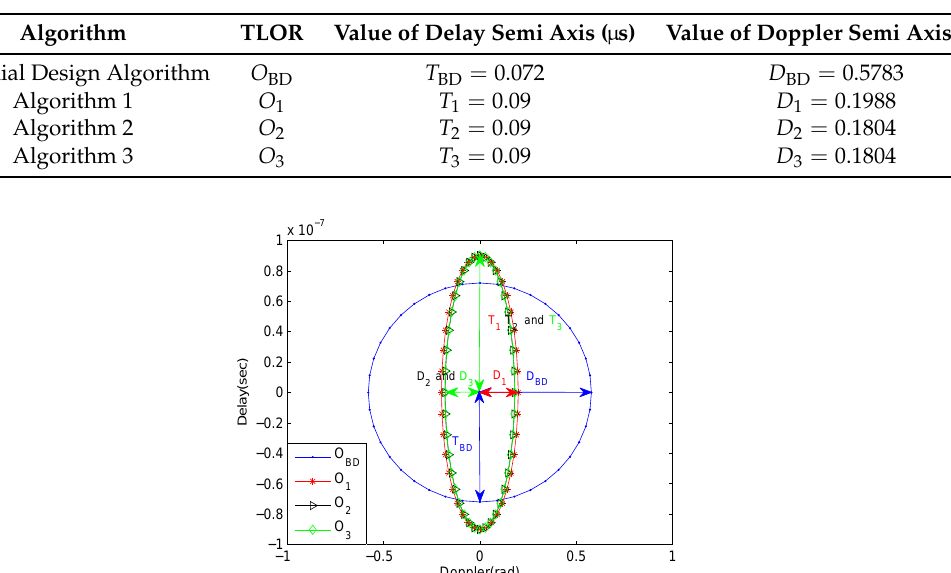
Table 2. Comparisons of the tolerable location offset region.